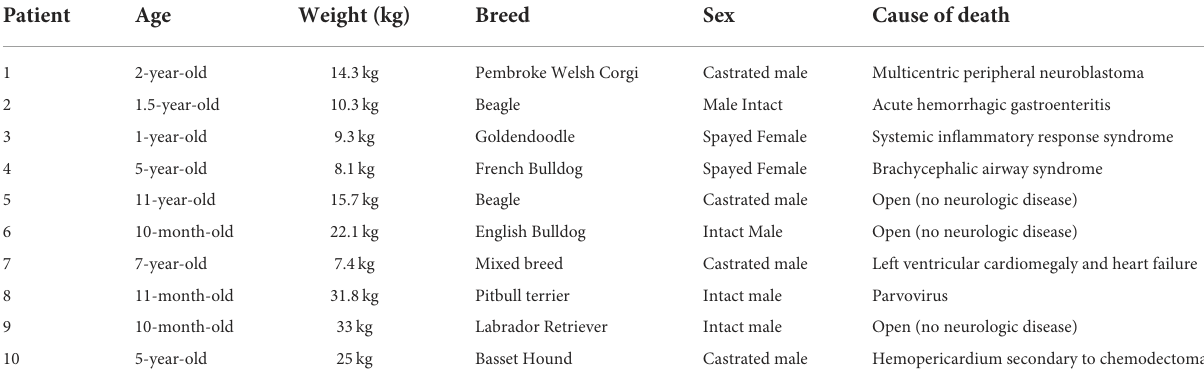
TABLE 1 Ten control dural biopsy specimens of dogs that died of causes unrelated to Chiari-like malformation